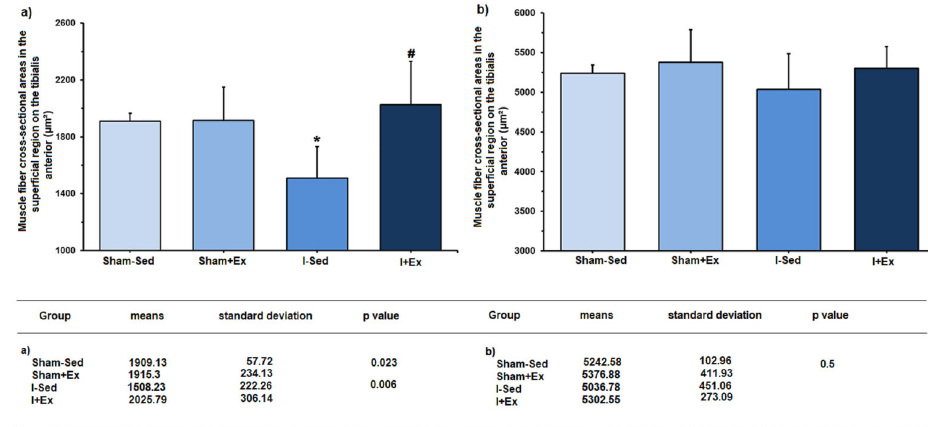
Figure 3. Muscle fi ber cross-sectional areas in the super fi cial region of the tibialis anterior muscle and table showing the numerical data. a , Type-I fi bers: *P=0.023 vs S ham-Sed group; # P=0.006 vs I-Sed. b , Type-II fi bers: P=0.5 Sham-Sed vs I-Sed group (ANOVA, followed by the Newman-Keuls post- test). Sham-Sed: Sedentary control group; Sham + Ex: Control group exercised before the sham surgery; I-Sed: Sedentary ischemic group; I + Ex: Ischemic group exercised before occlusion of the middle cerebral artery surgery.